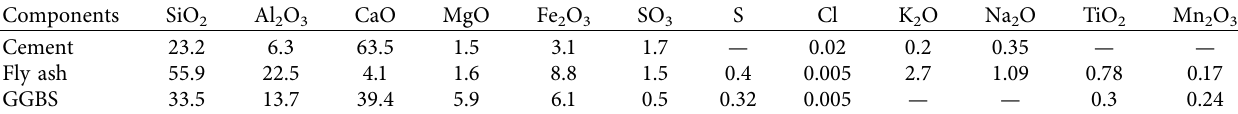
Figure 7: (a) M -sand in the RMC plant. (b) C -sand in the RMC plant. Table 5: Chemical composition of the binding material in % of the composition.